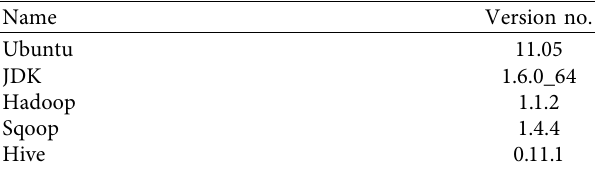
Table 3: List of software version numbers.